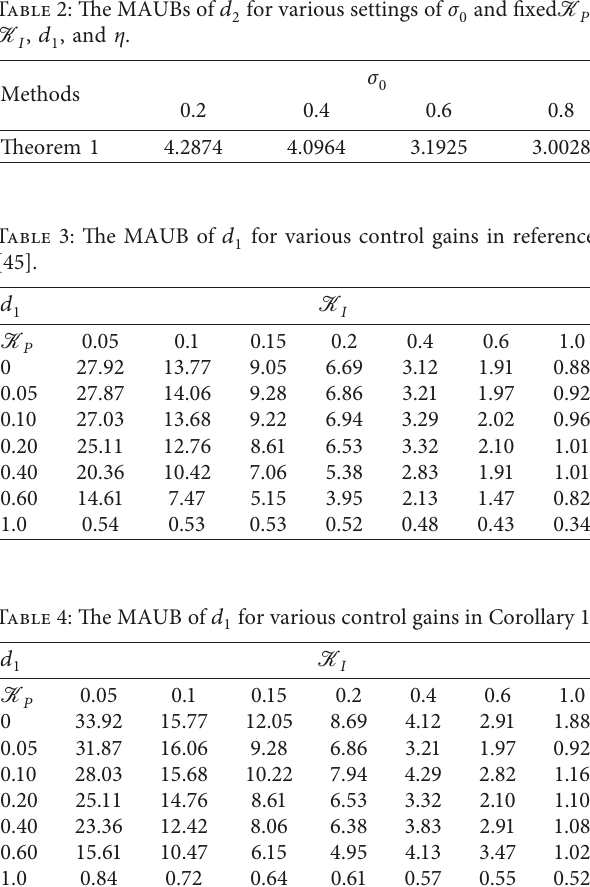
for various settings of σ 2